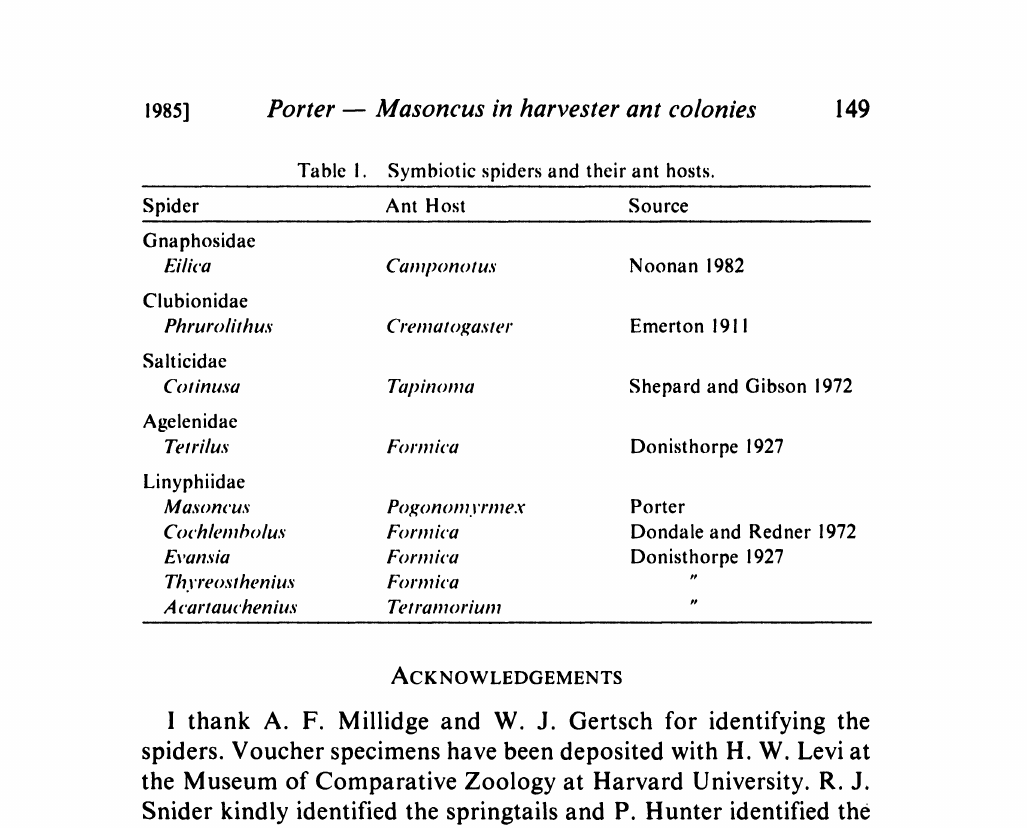
Table I. Symbiotic spiders and their ant